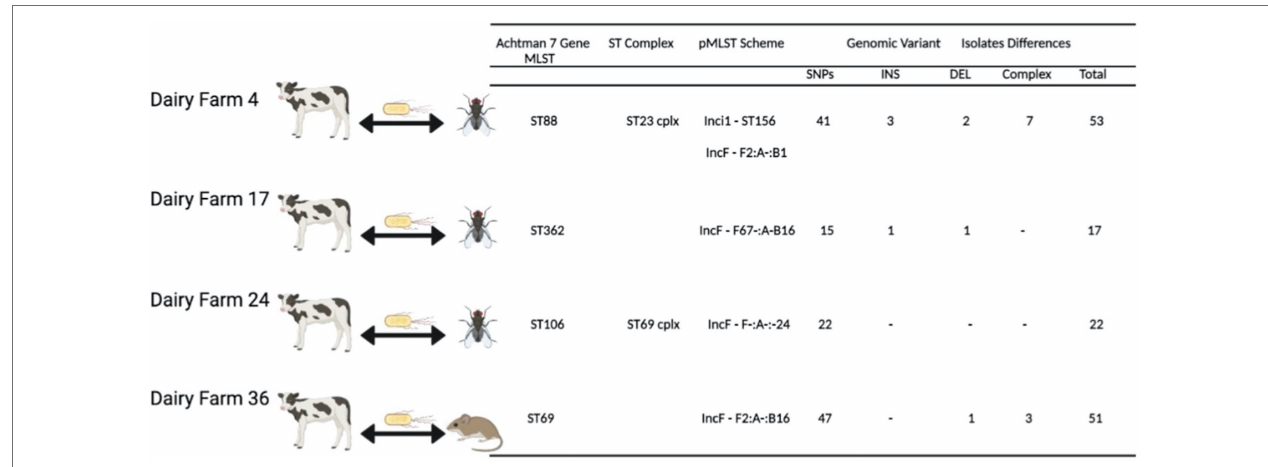
FIGURE 2 | Bacterial isolates from two different sources in the same farm that share the same Achtman 7 Gene MLST, ST complex number is stated when available and pMLST types for plasmid incompatibility groups are given for IncF and Inci1 plasmids. Genomic variants differing among isolates are sorted by types (SNP = single nucleotide polymorphism, INS = genomic insertion, DEL = genomic deletion, Complex = genomic difference that could be comprised of single nucleotide polymorphism and or genomic insertion and or genomic